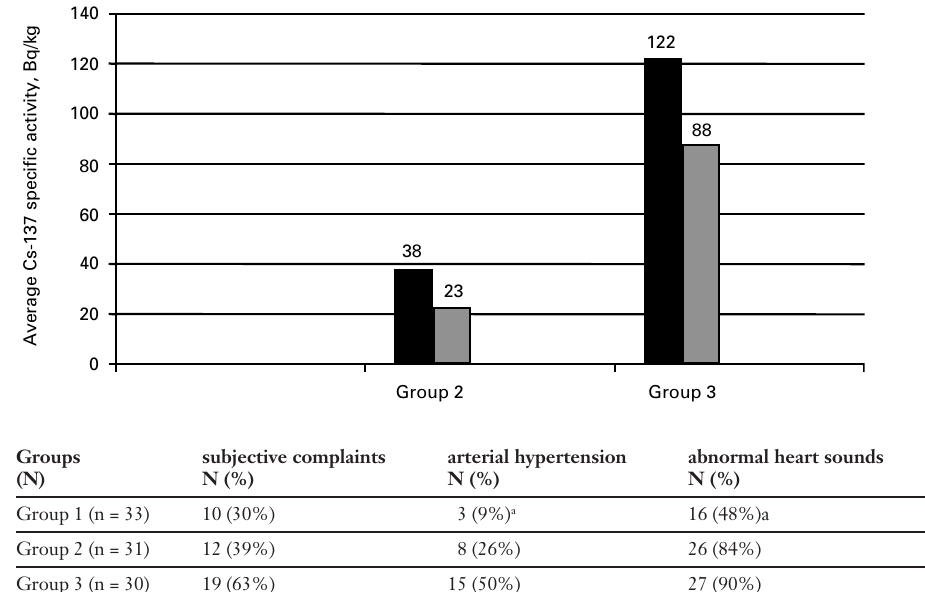
Clinical findings at study